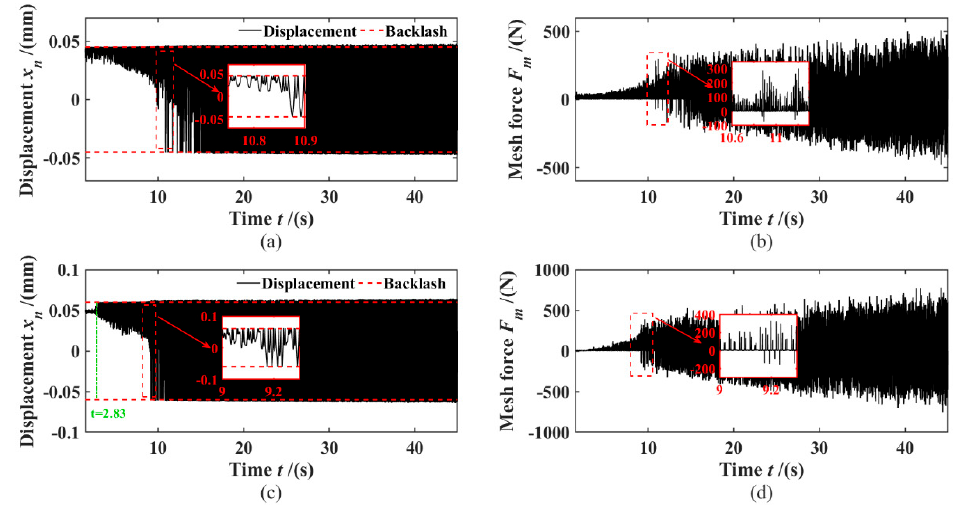
Figure 10. Dynamic response: ( a ) 3rd gear relative displacement; ( b ) 3rd gear meshing force; ( c ) 5th gear relative displacement; ( d ) 5th gear meshing force;.